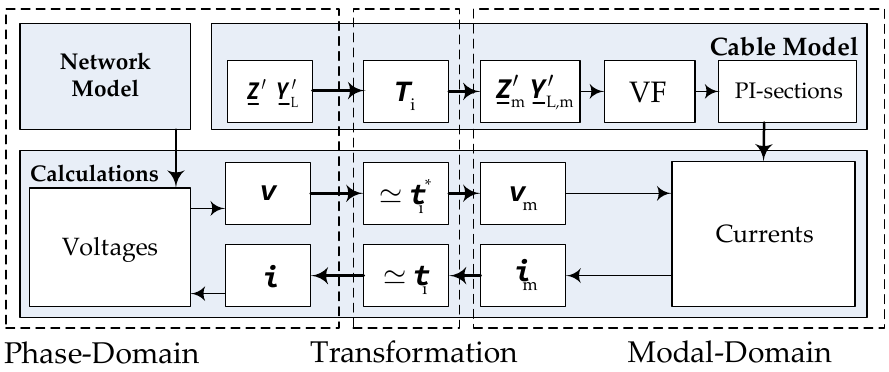
Figure 3. Principle of the 3phase cable